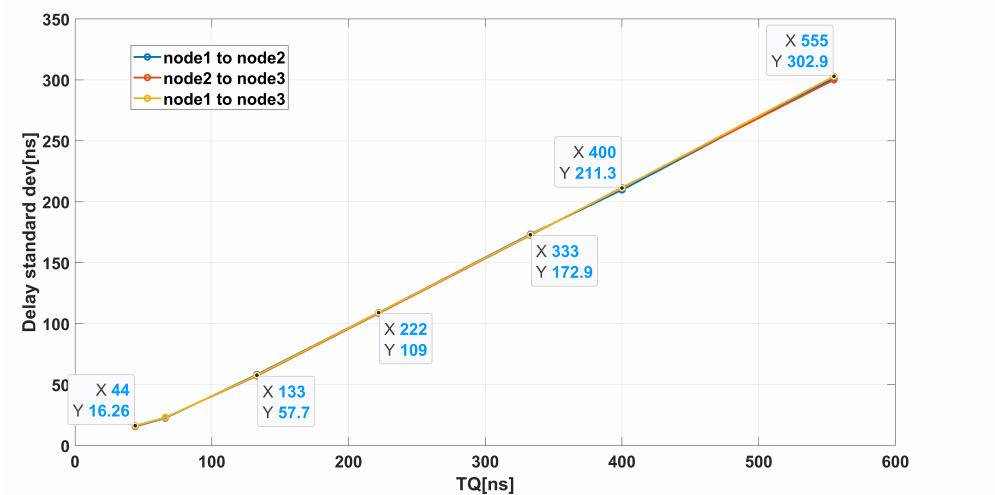
Figure 6. CAN peripheral synchronization: standard deviations of delays as a function of time quantum.